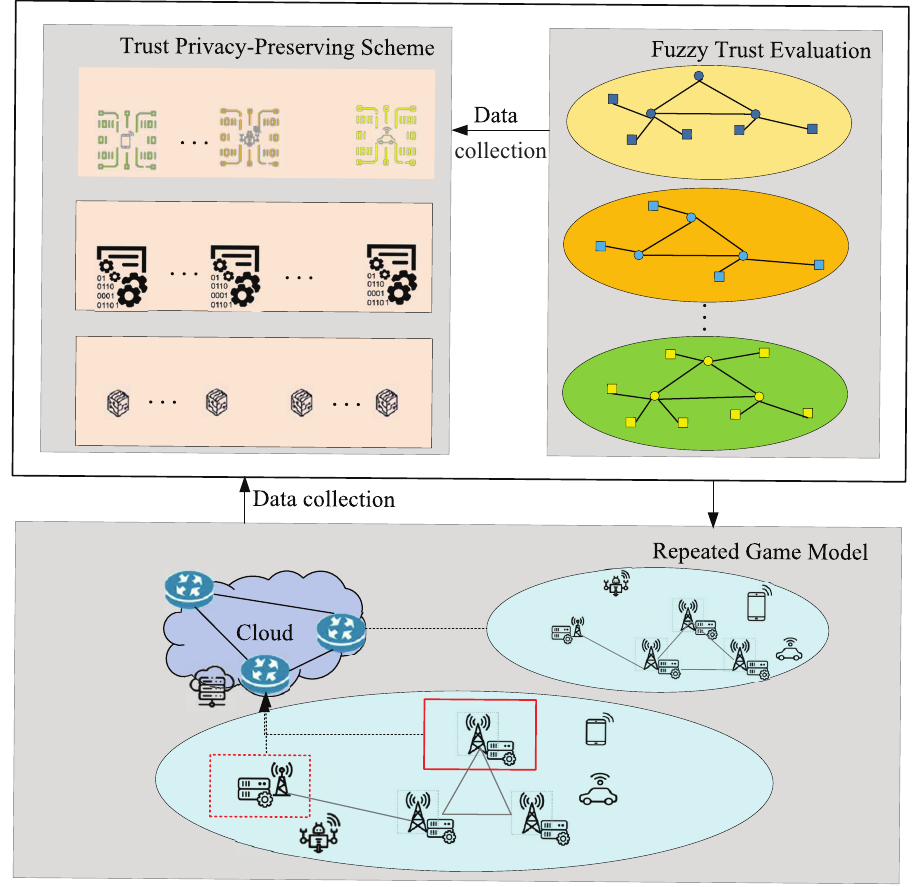
Figure 1. The framework of the fuzzy-based privacy-preserving scheme based on the repeated game. The devices in the solid line frame are common IoT devices in the cluster, and the dotted line is the routing device that guarantees data